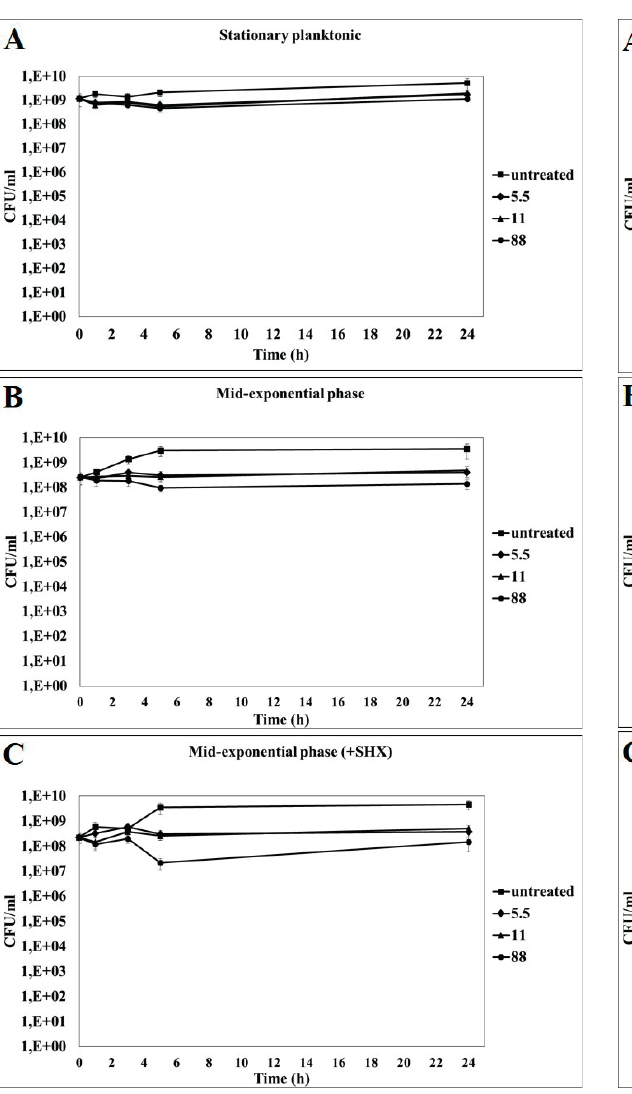
Fig. 3. Killing of P. aeruginosa PAO1 wild-type cells by tobra- mycin. Cells of stationary-phase (A), exponential-phase without SHX (B) and exponential-phase cultures with SHX (C) were exposed to 6.5-, 13- and 104-μg/mL of tobramycin (MIC is 1.3 μg/mL) for 1, 3, 5 and 24 h and then plated for colony forming units (CFU/mL). The percent survival is not shown. The values are averages of three independent experimetns and error bars are not shown, and the error bars indicate the standard error of the